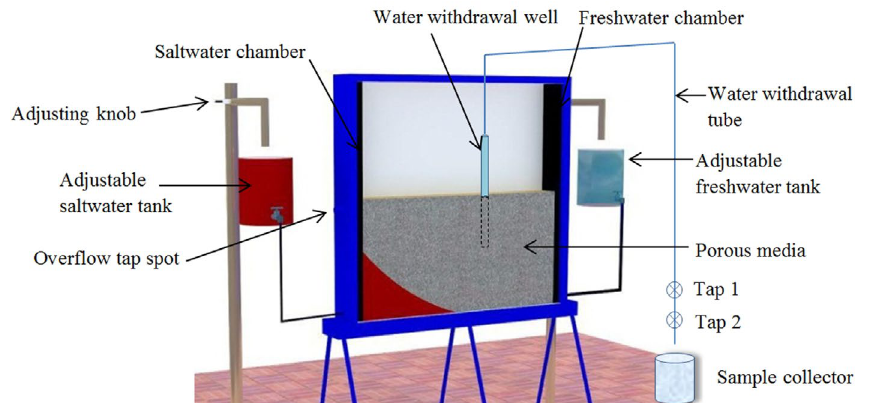
Fig. 1: Details of the experimental box used in this study